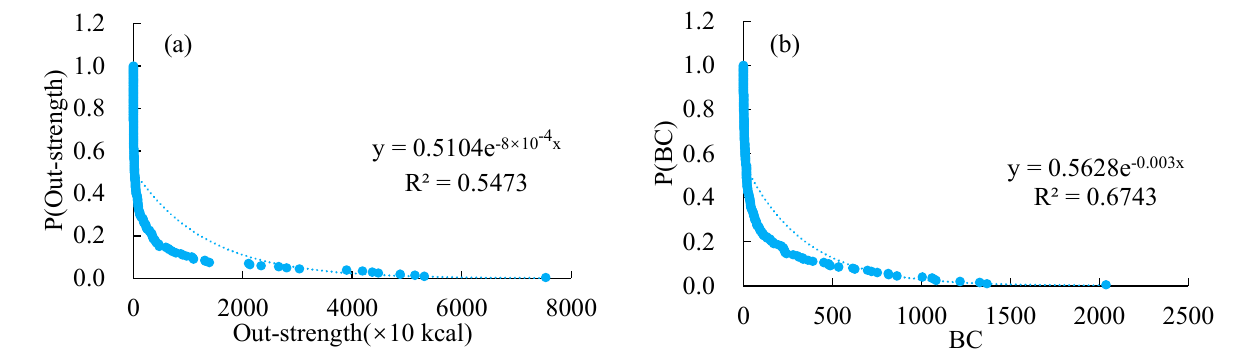
Figure 3. Probability distribution of strength-out degree ( a ) and BC ( b ). Table 3. Characteristics of the top 20 countries in the CCFTN.